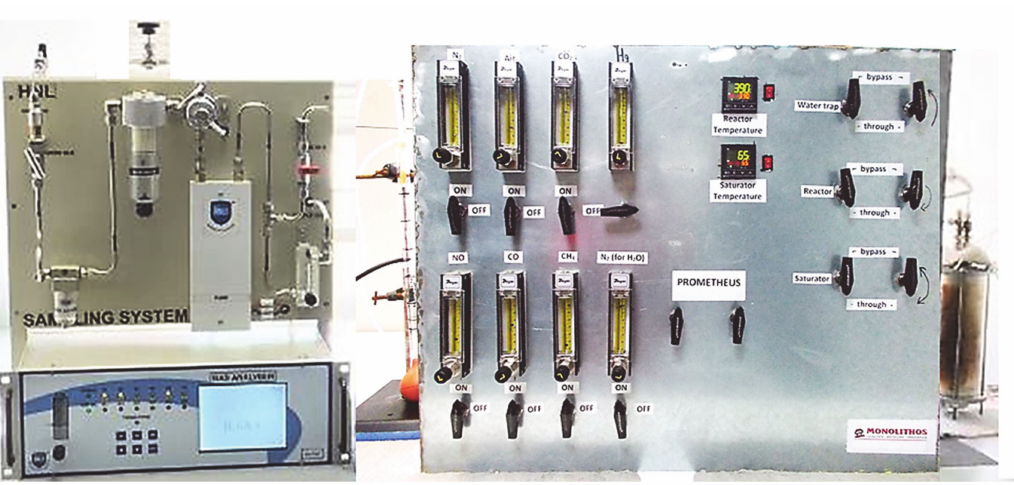
Figure 8. Catalyst activity lab-scale testing setup (SGB apparatus). Table 2. Selected gas mixtures concentrations for λ = 0.99 and λ = 1.03.